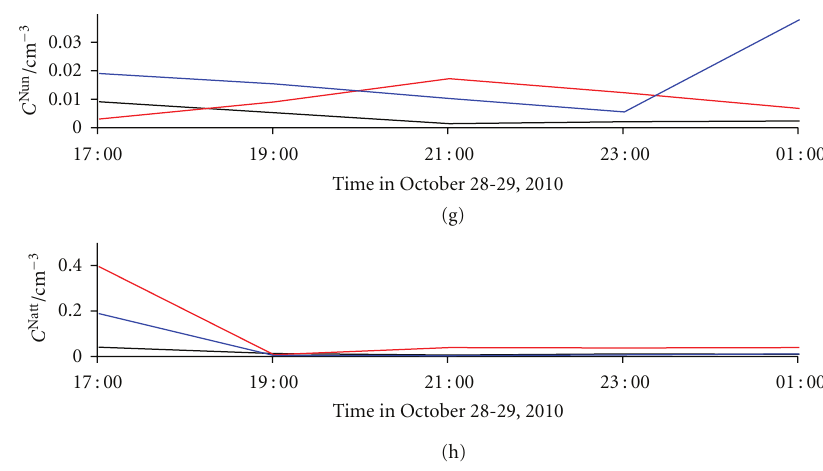
Figure 11: Time run of: (a) total number concentration of general aerosol particles ( C N (tot)) and geometric mean values of their diameters gen ( d GM ), (b) activity concentration of radon ( C A ) and equilibrium equivalent activity concentration of radon decay products ( C A ), (c) Rn RnDP number fraction of particles smaller than 10 nm ( x gen ( < 10)) and smaller than 20 nm ( x gen ( < 20)), (d) activity fraction of the unattached RnDP , C Aun 214 , and ( f un ) and number fraction of the unattached RnDP ( x un ), (e) activity concentrations of the unattached RnDP atoms ( C Aun 218 Pb Po C Aatt C Aatt C Aatt C Aun 214 Bi ), (f) activity concentrations of the attached RnDP atoms ( 218 Po , 214 Pb , and 214 Bi ), (g) number concentrations of the unattached , C Nun 214 , and C Nun 214 ), and (h) number concentrations of the attached RnDP atoms ( C Natt 218 , C Natt 214 , and C Natt 214 ), in RnDP atoms ( C Nun 218 Pb Bi Pb Bi Po Po indoor air for the period October 28-29 (with opening of the window in the kitchen at 16:50 on October 28).